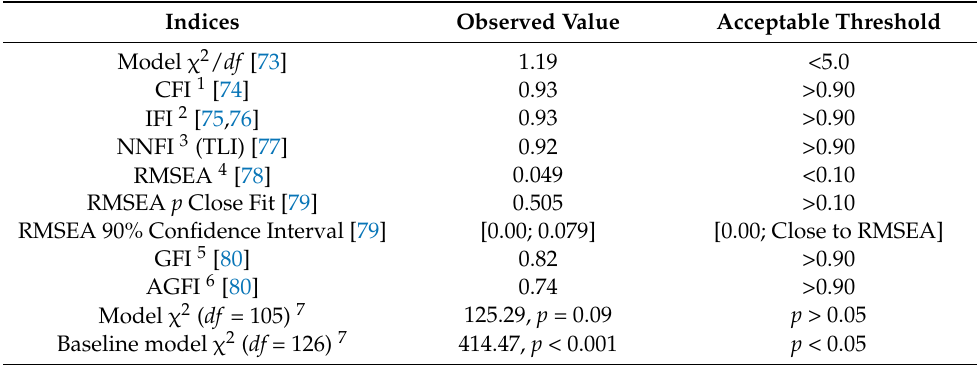
Table 3. Observed fit indices and appropriate thresholds for the structural equation model of the French sample. Indices Observed